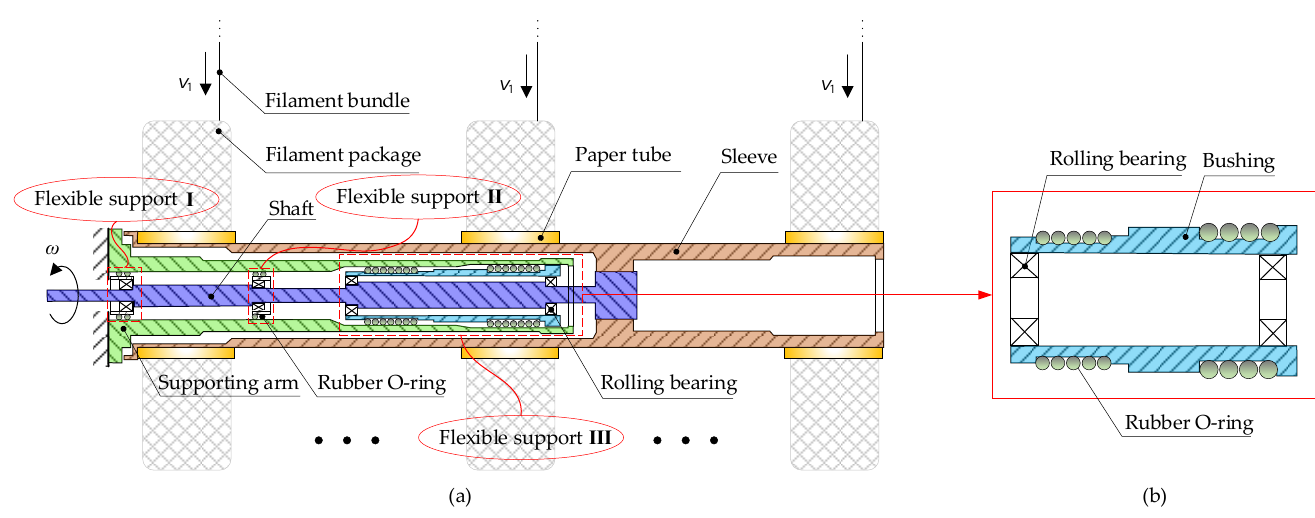
Figure 1. Layout of main structure of the winding rotor. ( a ) Winding rotor, where I II III denote the flexible supports with different rubber O-rings, respectively; ( b ) flexible support structure.